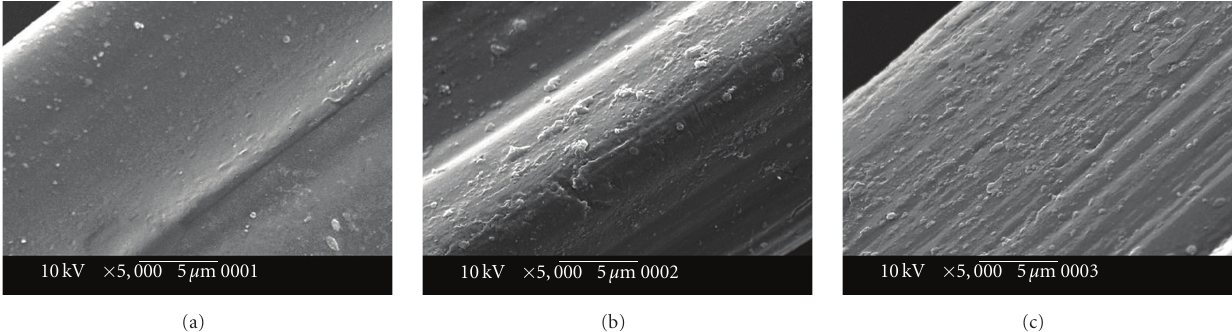
Figure 4: SEM images of the surfaces of the A. pernyi silks obtained at di ff erent spinning speeds: (a) 25 mm/s, (b) 68mm/s, and (c) 100mm/s.